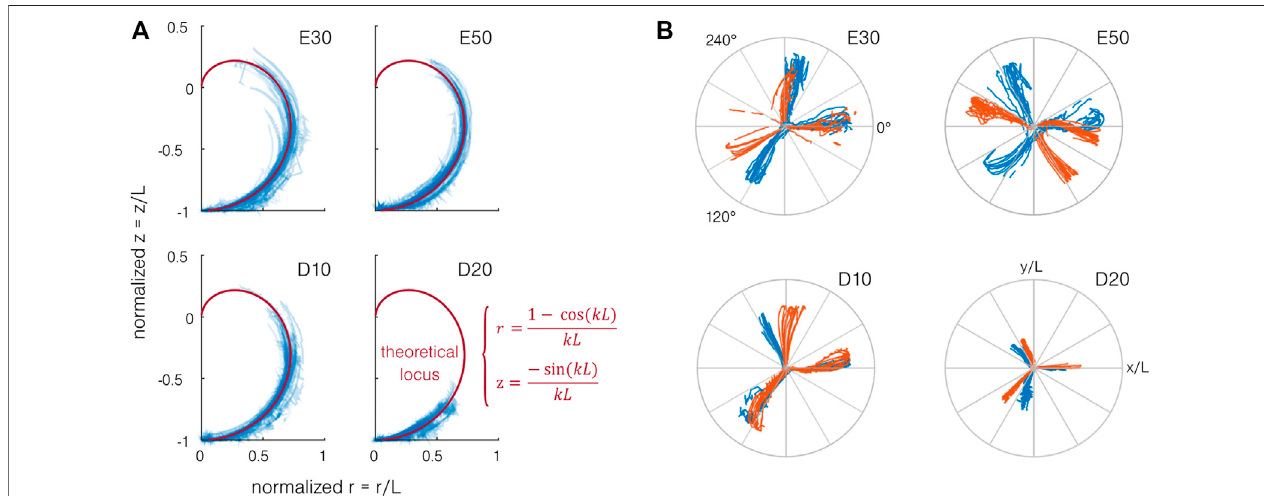
FIGURE 7 | Working space of the actuator. (A) When projected on a vertical plane Orz , the end position of the end marker of the actuator (in blue) follows the theoretical locus (in red) for each material. (B) When projected on the Oxy plane and normalized by the actuator length, the position of the end marker shows a large differencefromtheexpected120 ° separationofthebendingdirectionsforeachchannel.Twoactuatorspermaterialarerepresented,eachcolorindicatingoneactuator. Normalized top view of the end marker position for each sample. The two colors indicate the two samples.